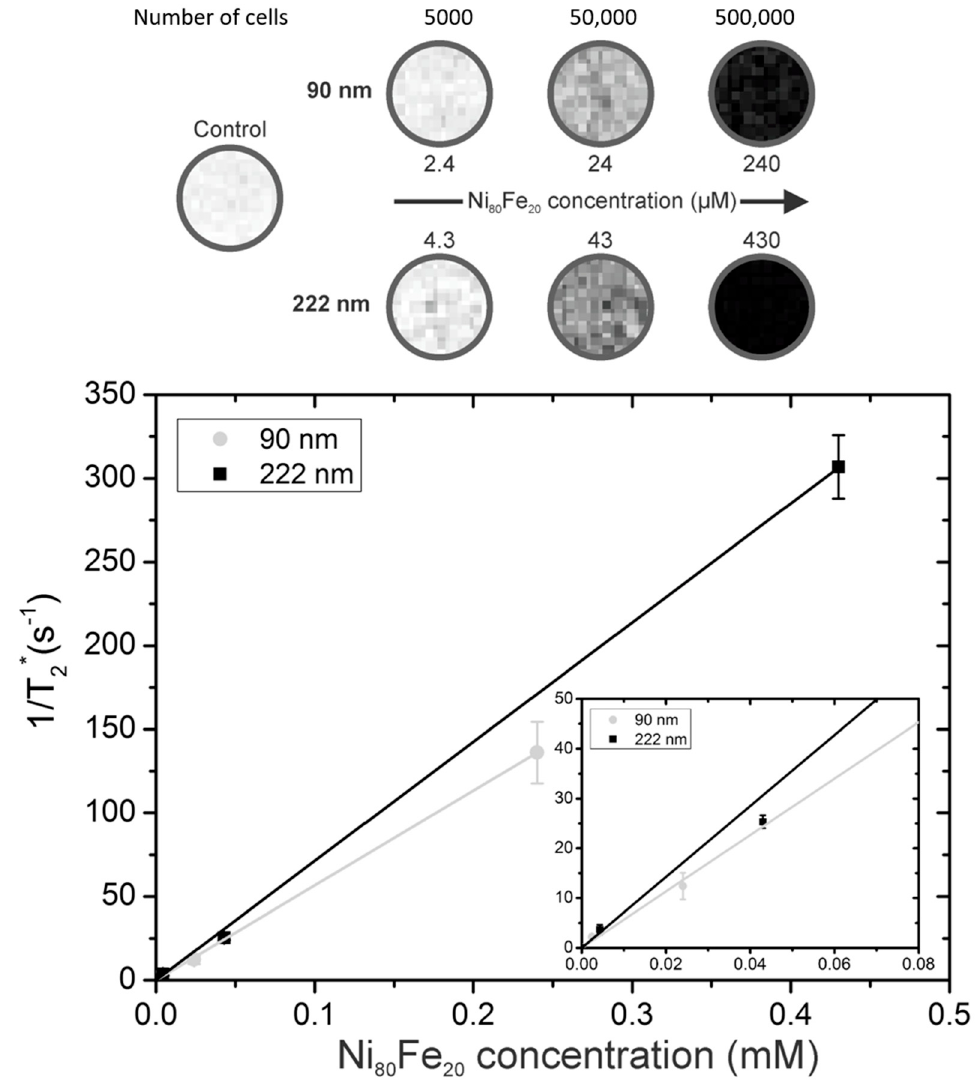
Figure 2. MRI of the SAF-NP labeled cells. (top) T2*-weighted MR images of the homogeneously suspended SAF-NP-labeled SKOV 3 cells in an agar phantom at an echo time of 38 ms for the given cell number and Ni 80 Fe 20 concentration. The control sample contained 500,000 unlabeled cells. (bottom) Plot of the resulting 1/T2* values as a function of the intracellular Ni 80 Fe 20 concentration. The inset is a magnification at lower Ni 80 Fe 20 concentrations.